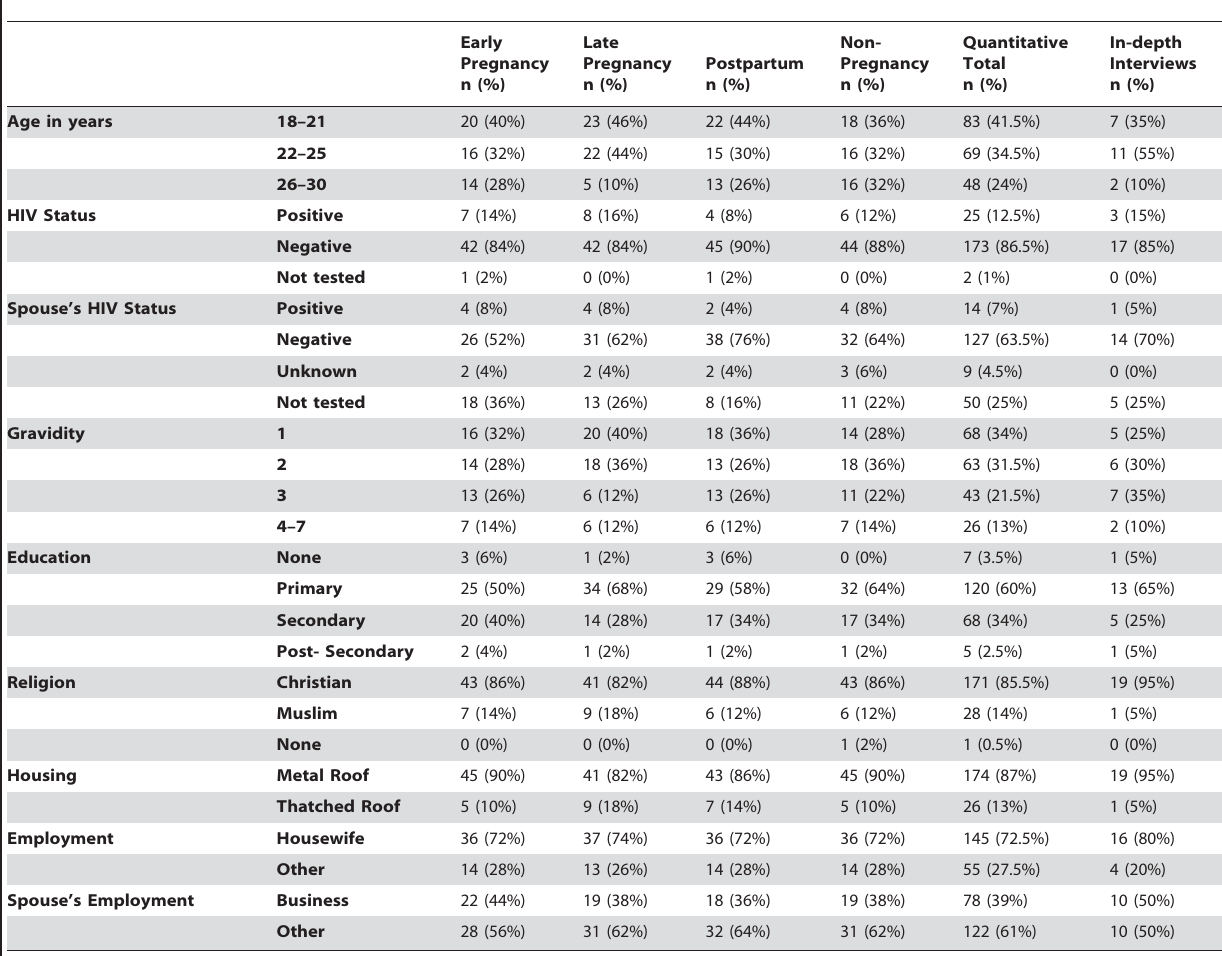
Table 1. Characteristics of quantitative groups and in-depth interview group.